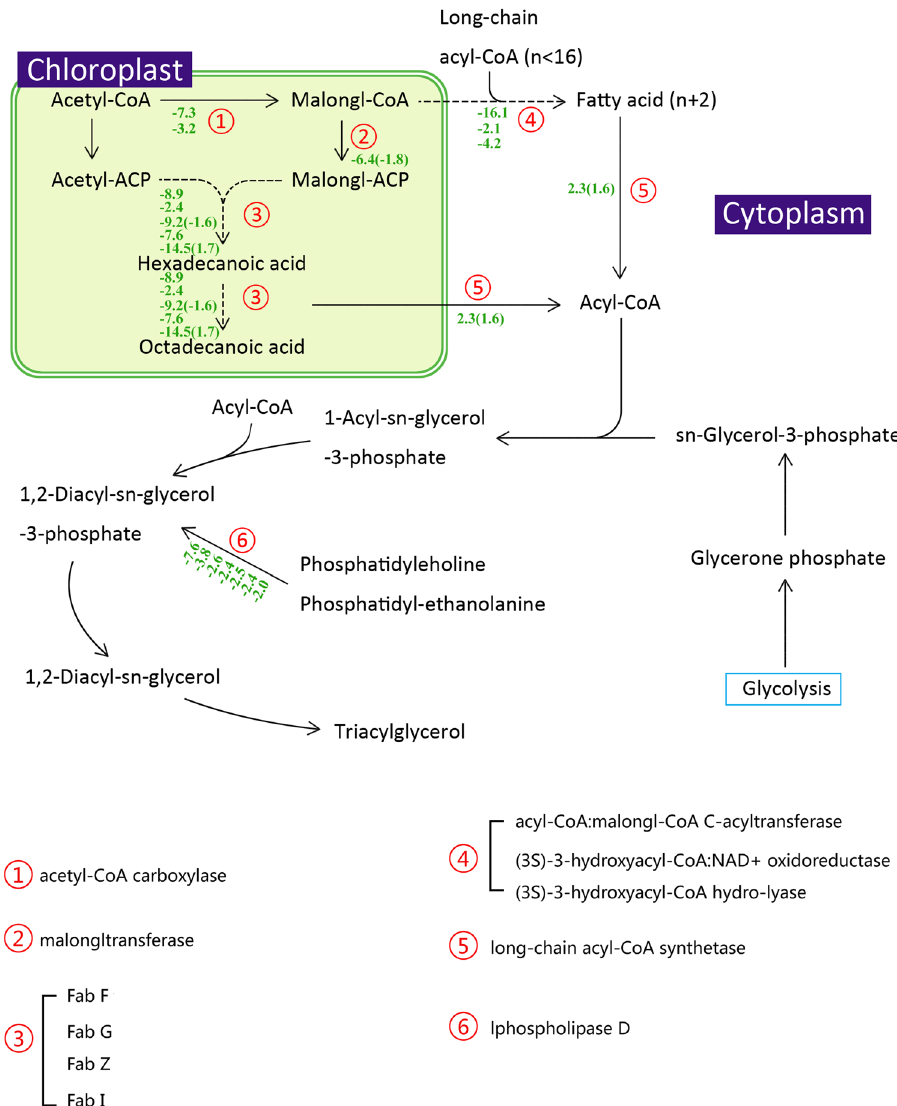
Figure 6. The lipid synthesis and metabolism pathway in T. pseudonana during N depletion compared to N replete conditions (ND vs. NR). The serial number represent the related enzyme and the negative number indicate the down-expressed fold change of the genes (The opposite is up-expressed). The Inside the parentheses is the protein fold change. There are serval genes in one